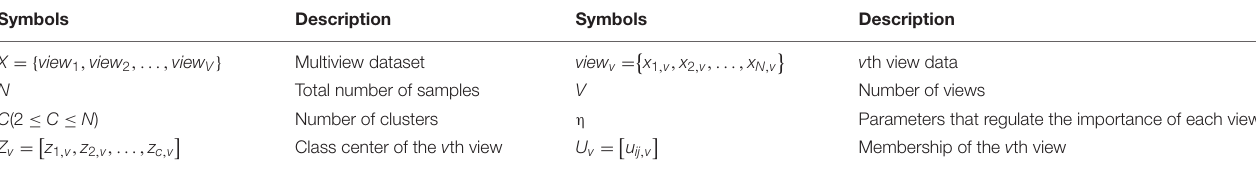
TABLE 4 | Description of related symbols in the multiview clustering algorithm.